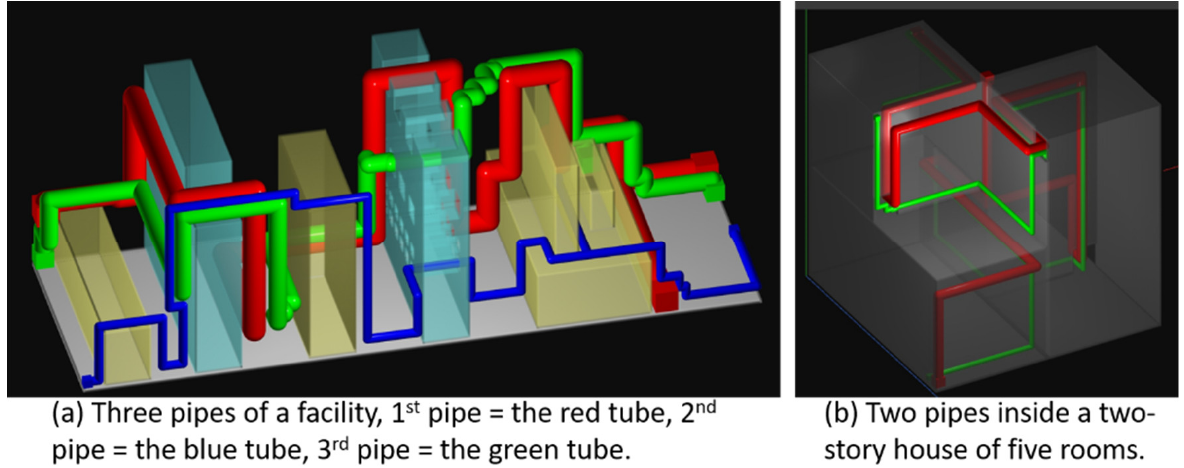
Figure 6. ( a ) Routing 3 pipes in a machinery room, ( b ) routing 2 pipes in a 2-story